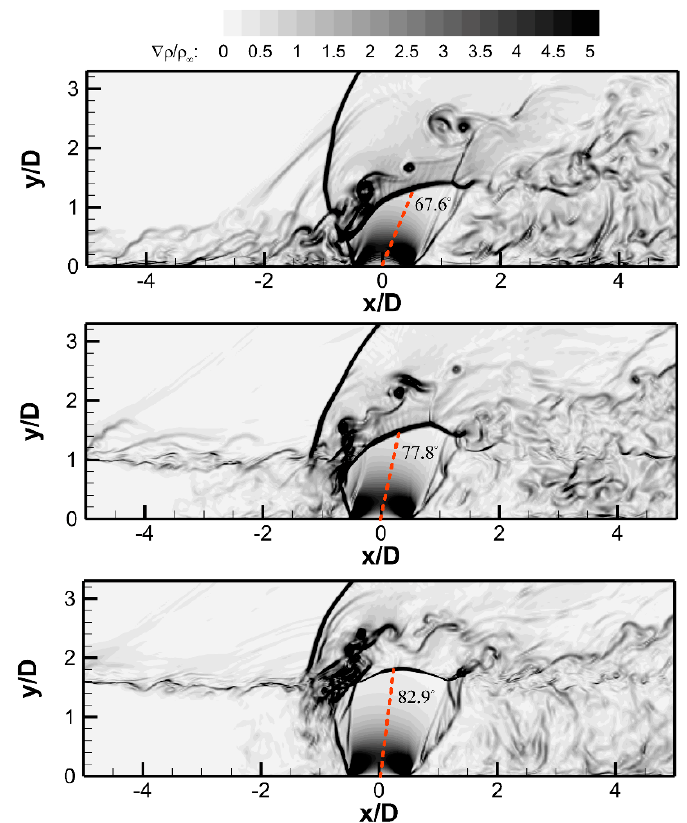
Figure 9. Instantaneous snapshots of the density gradient magnitude at the midline plane of z/D = 0. Turbulent vortices play an important role in the mixing process, especially the shear vortex on the windward surface, which dominates the near-field entrainment-stretching-mixing process. To show the three-dimensional structure of the vortex, Figure 10 shows the mixture fraction isosurface colored by the vorticity magnitude and the λ 2 isosurface colored by the streamwise velocity. According to the isosurface of the mixture fraction (left side), the windward surface of the jet folds and rolls up large-scale eddies due to the K-H instability. As the large-scale recirculation zone formed by the steps rises, the upwind shear vortex appears farther away from the wall at a smaller scale. Observing the vorticity distribution on the isosurface, the region of high vorticity caused by the strong shear at the jet exit is gradually dispersed. Under the influence of larger-scale CVPs, the vorticity of the downstream near-wall area is stronger, which is beneficial for mixing in the leeward area. The right figure shows the hairpin vortex of the boundary layer / shear layer and the vortex tube of the jet in the windward region by using the λ 2 criterion. Under basic conditions, the vortexes in the near field are larger because of the stronger shear, and it gradually breaks down to form smaller-scale vortexes. The streamwise velocity distribution on the surface of the vortex tube indicates that the velocity in cases 2 and 3 is lower, which is closer to the mainstream velocity, and the shear is weaker than in case 1. Therefore, the step weakens the shear of the jet outlet, and the vorticity scale in cases 2 and 3 is